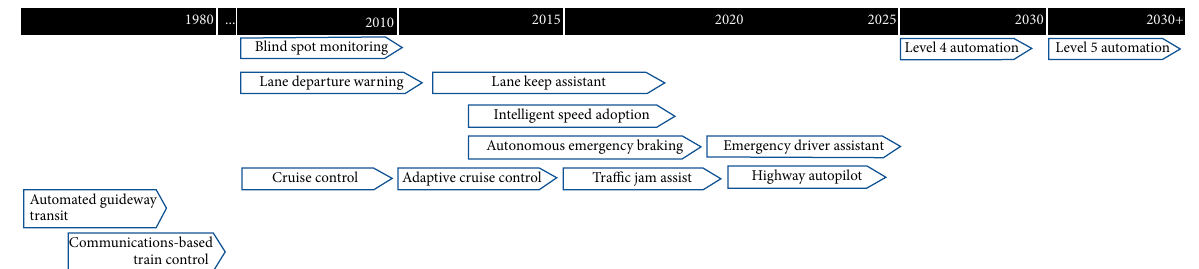
Figure 2: Transit autonomy timeline (